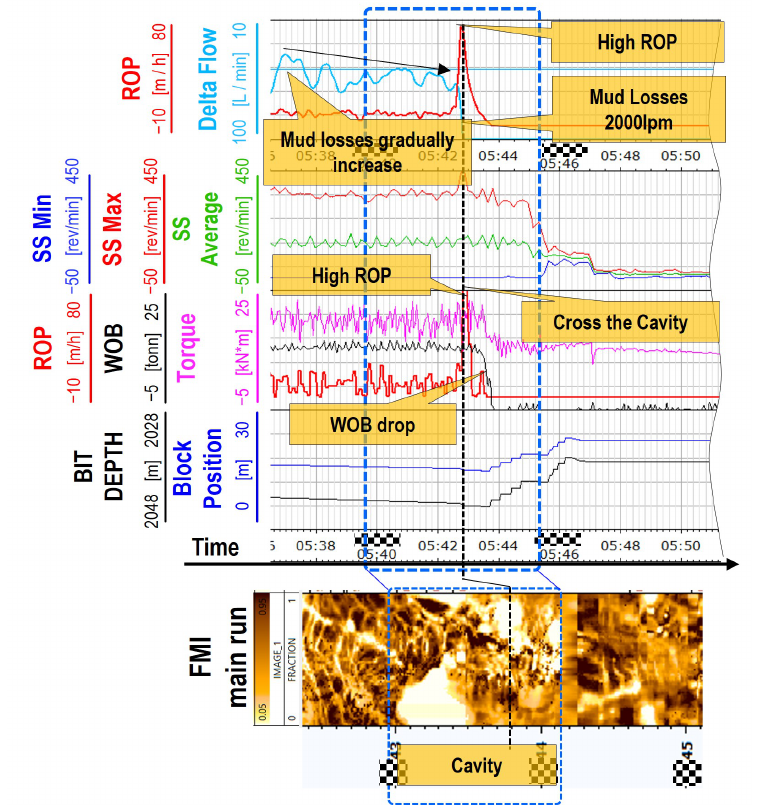
Figure 6. Drilling mechanics data in the interval of cavity based on the field data from the Loppa High region—courtesy of Lundin Energy. See Table 1 for the description of the logged